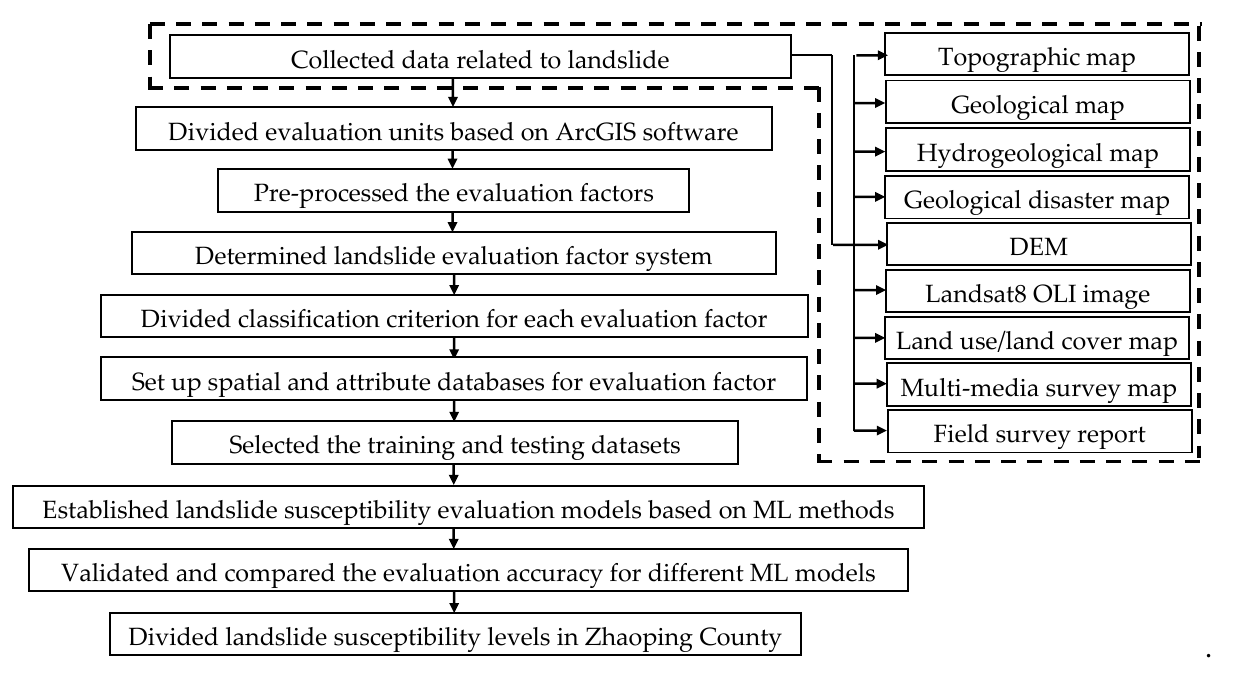
Figure 3. Flowchart of landslide susceptibility evaluation based on machine learning (ML).